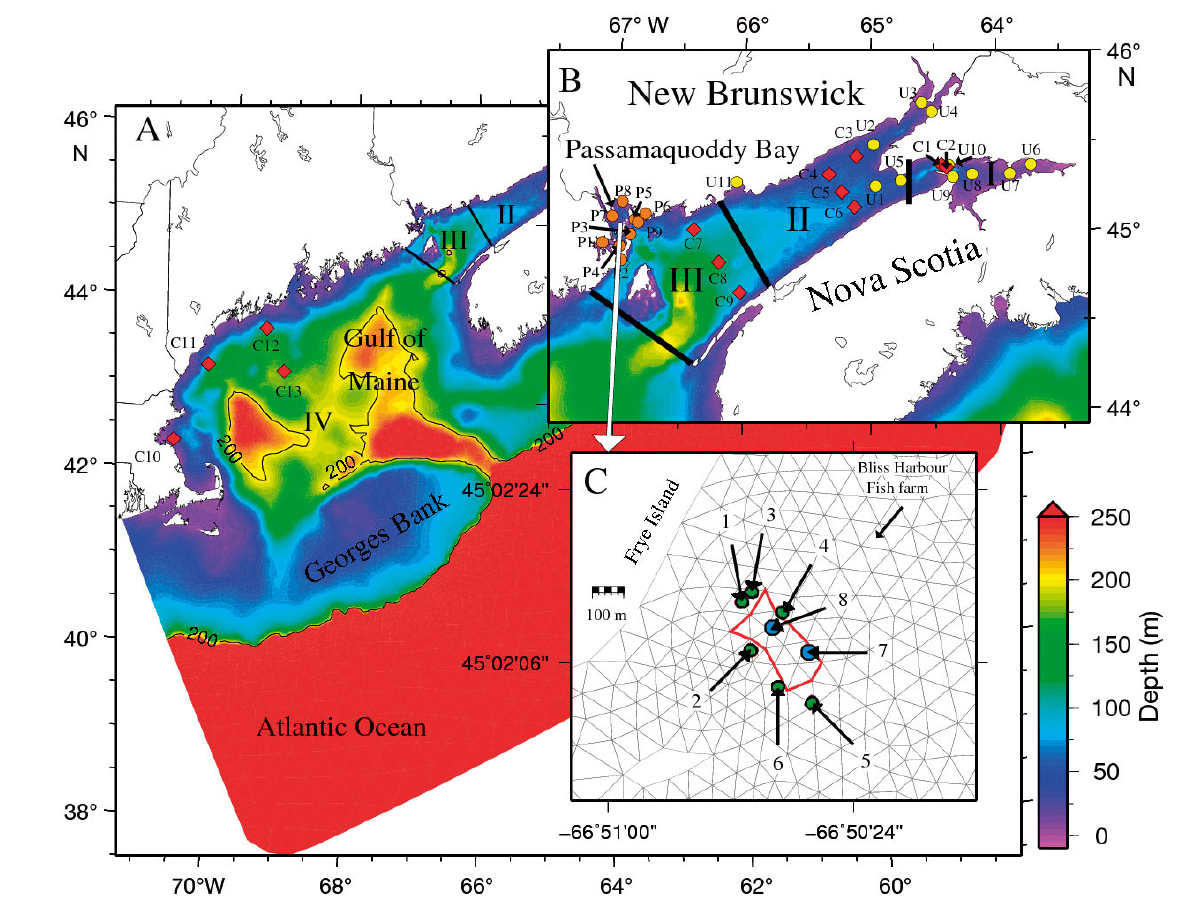
Fig. 1. (A) Model domain, (B) the Bay of Fundy and (C) mesh in the study area. (A, B) Locations of ( ) tidal level data in the up- per Bay of Fundy (U1 to U11), ( d ) tidal level data in Passamaquoddy Bay (P1 to P9), and ( ) current data used in Table 3 (C1 to C13). I, II, III and IV stand for the upper Bay of Fundy, lower Bay of Fundy, outer Bay of Fundy and Gulf of Maine, respectively. (C) Locations of the moored acoustic Doppler current profilers (nos. 1 to 8) are shown, including those at the ( ) edge and ( ) interior of the farm (red outline) Table 1. Observed and modelled amplitude and phase, and discrepancies of M 2 tidal elevations in the upper Bay of Fundy (locations of the sites are shown in Fig.